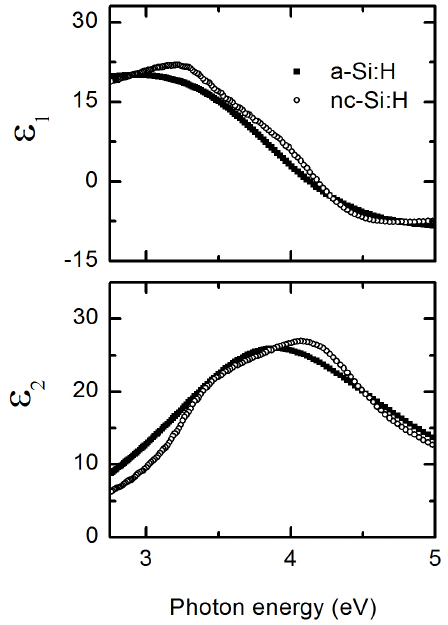
Figure 5. Spectra in ε (top panel, real part ε 1 ; bottom panel, imaginary part ε 2 ) of a ‐ Si:H and nc ‐ Si:H reference material used in VIA applied over a spectral range from 2.75 to 5.0 eV. Spectra in ε for a ‐ Si:H and nc ‐ Si:H were obtained from analysis of RTSE data and by numerical inversion at a bulk layer thickness of 200 and 1150 Å, respectively.